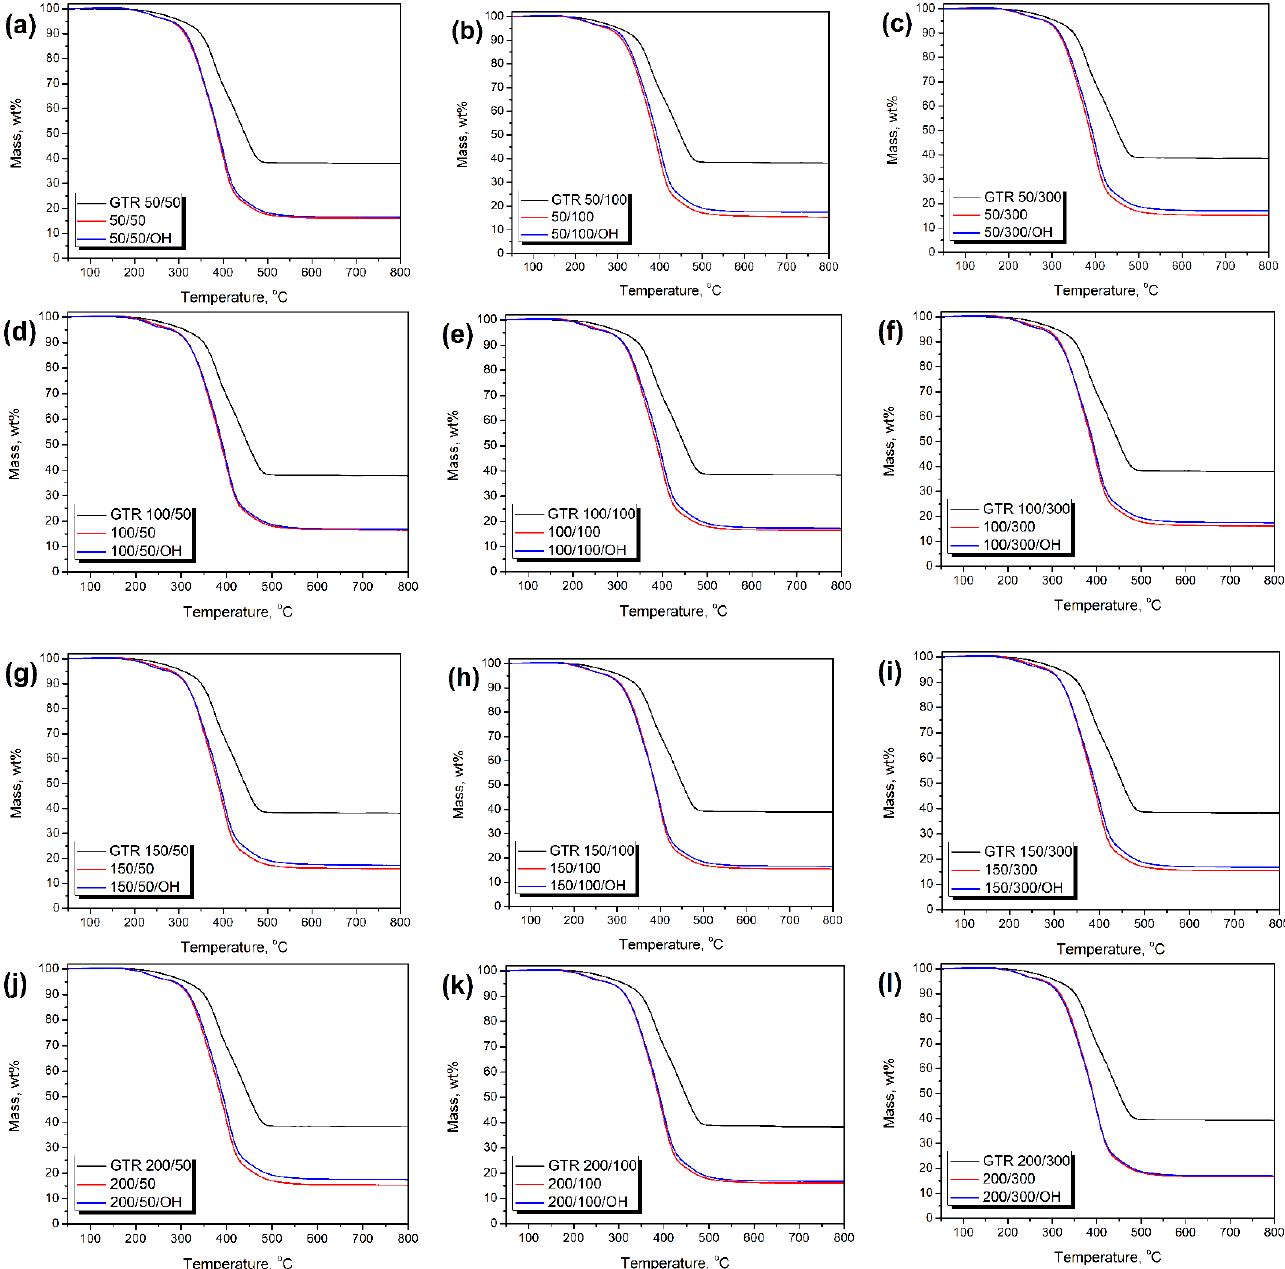
Figure 12. Mass loss curves obtained during thermogravimetric analysis of thermomechanically treated GTR samples and PU composite foams containing different GTR types: ( a ) 50/50, ( b ) 50/100, ( c ) 50/300, ( d ) 100/50, ( e ) 100/100, ( f ) 100/300, ( g ) 150/50, ( h ) 150/100, ( i ) 150/300, ( j ) 200/50, ( k ) 200/100, and ( l ) 200/300.